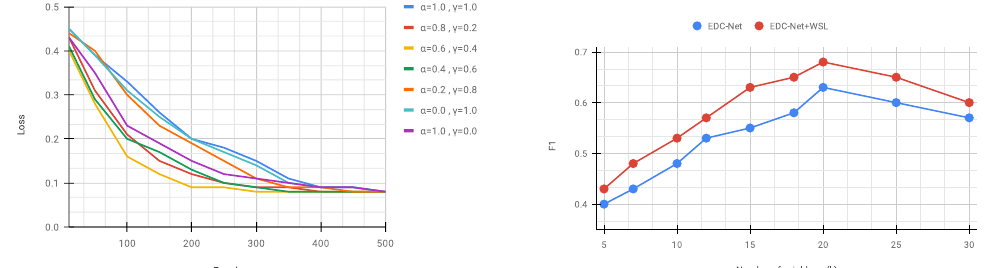
Figure 4. ( Left ) Training loss of EDC-Net for various α and γ during training on the ABC dataset. ( Right ) Comparison of the accuracy ( F 1 ) of EDC-Net on ShapeNet dataset based on various numbers of neighbors ( K ) and a comparison to demonstrate the importance of WSL (weakly-supervised learning) to improving the accuracy on ShapeNet dataset.